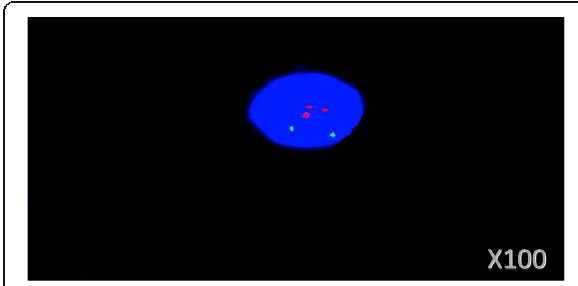
Fig. 1 FISH using hTERT (5p15) spectrum red and control on 5(q)spectrum green show amplification of hTERT (three red signals) in the interphase nucleus from MM patient